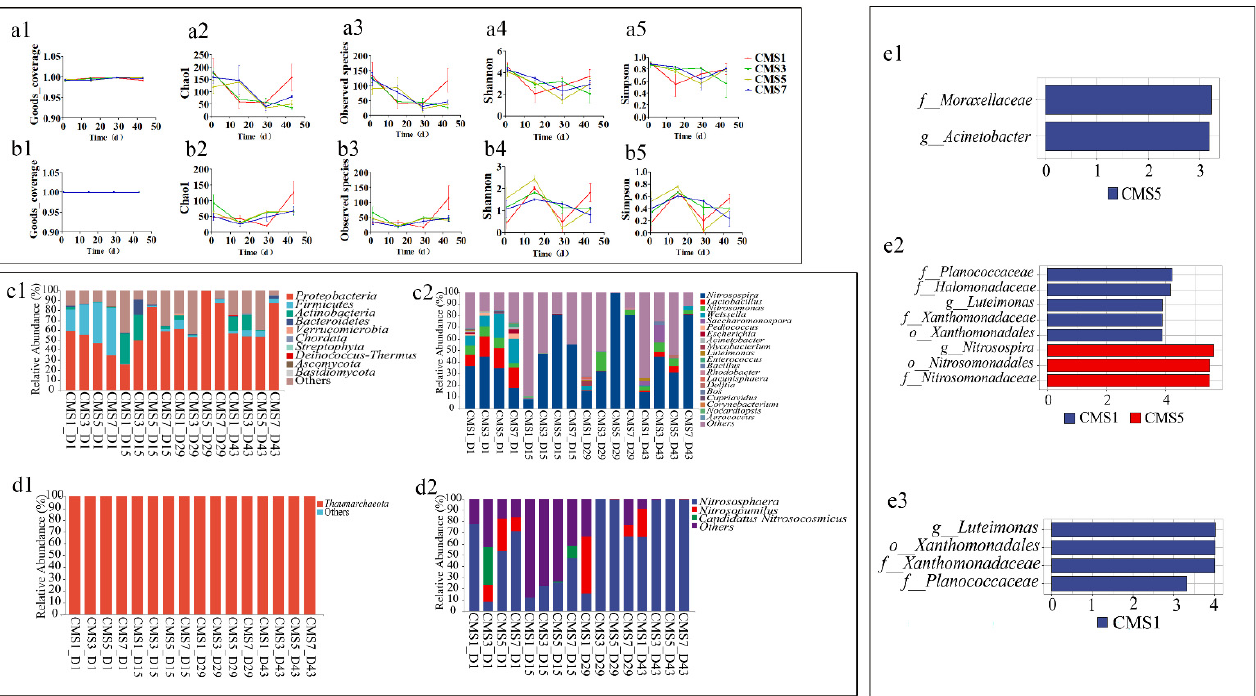
Figure 4. Changes of AOB and AOA community structure in different treatments during the composting. The α diversity of AOB community ( a1 – a5 ) and AOA community ( b1 – b5 ) in different treatments during the composting. The relative abundance of different bacteria at the phylum levels of AOB ( c1 ) and AOA ( d1 ) and genus levels of AOB ( c2 ) and AOA ( d2 ) in different treatments during the composting. LDA Effect Size (Lefse) analysis of the biomarkers (( e1 – e3 ) represent day 15, 29 and 43 for AOB, respectively,) with significant and biological differences from the phylum level to the genus level (LDA score > 3, p <